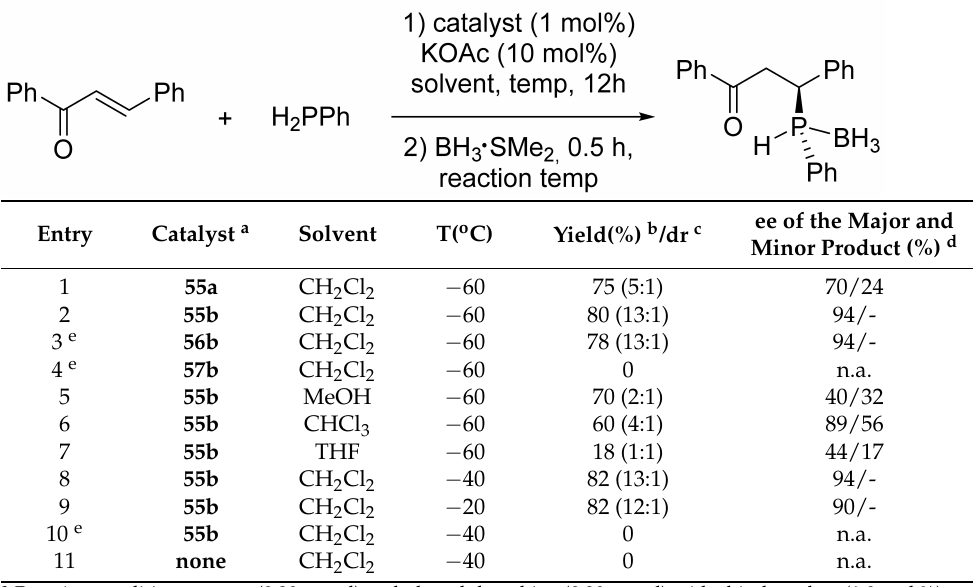
Table 6. Catalytic synthesis of P-stereogenic secondary phosphine-boranes with unsymmetrical PCP (cid:48) nickel pincer complexes 55a, 55b, 56b and 56b .